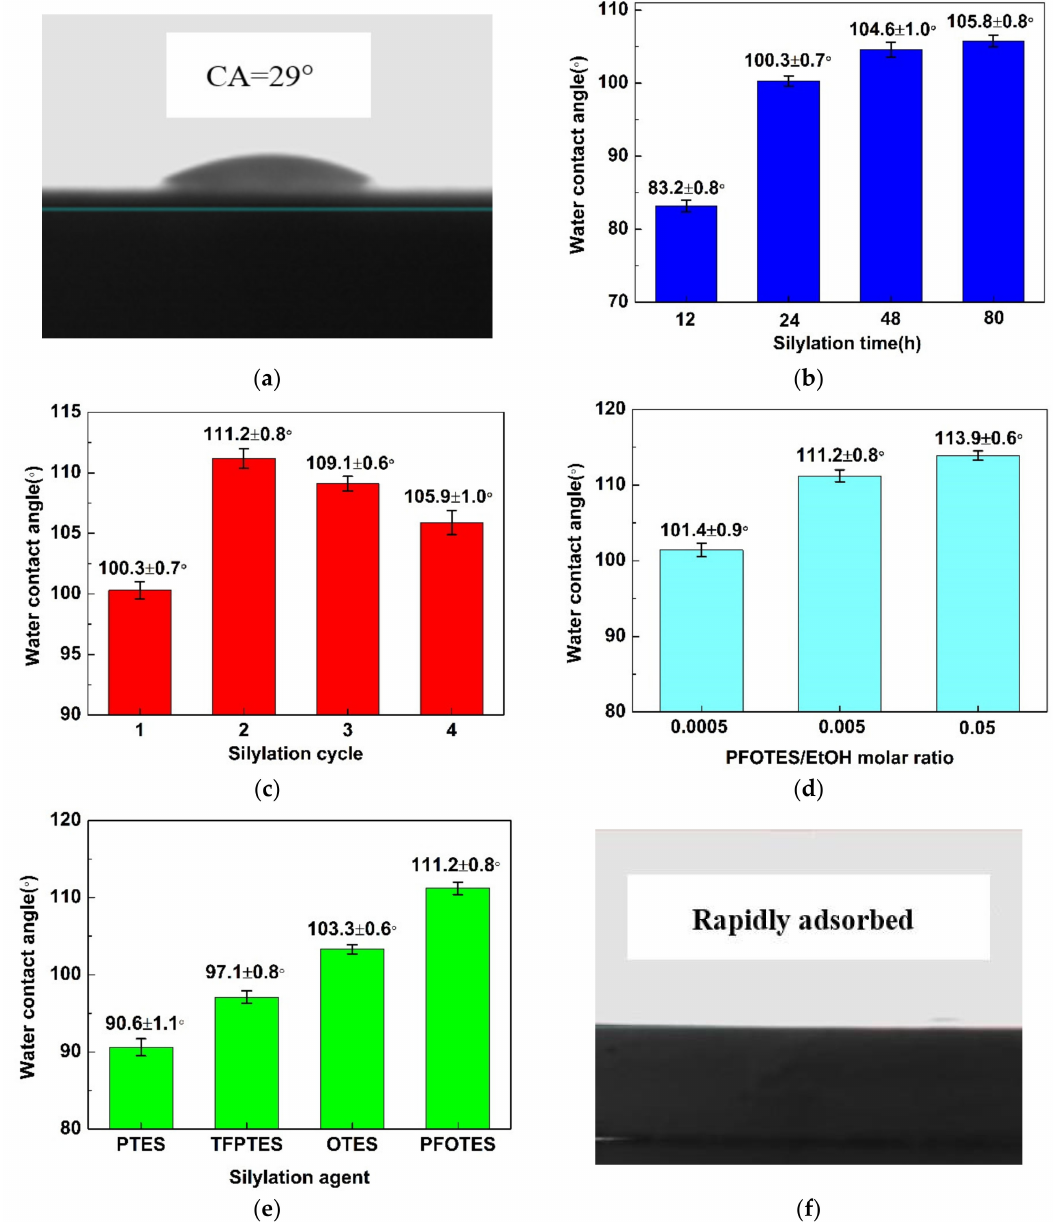
Figure 4. The surface silylatin of silica membranes: ( a ) water drop profile on pristine silica membrane; ( b )silylationperioddependenceofthewatercontactangleof1H,1H,2H,2H-perfluorooctyltriethoxysilane (PFOTES)-SiO 2 membrane; ( c ) silylation cycle dependence of the water contact angle of PFOTES-SiO 2 membrane; ( d ) water contact angle of silica membrane silylated with di ff erent PFOTES / EtOH molar ratio; ( e ) water contact angle of silica membrane silylated with di ff erent grafting agents; ( f ) MTBE drop profile on PFOTES-SiO 2